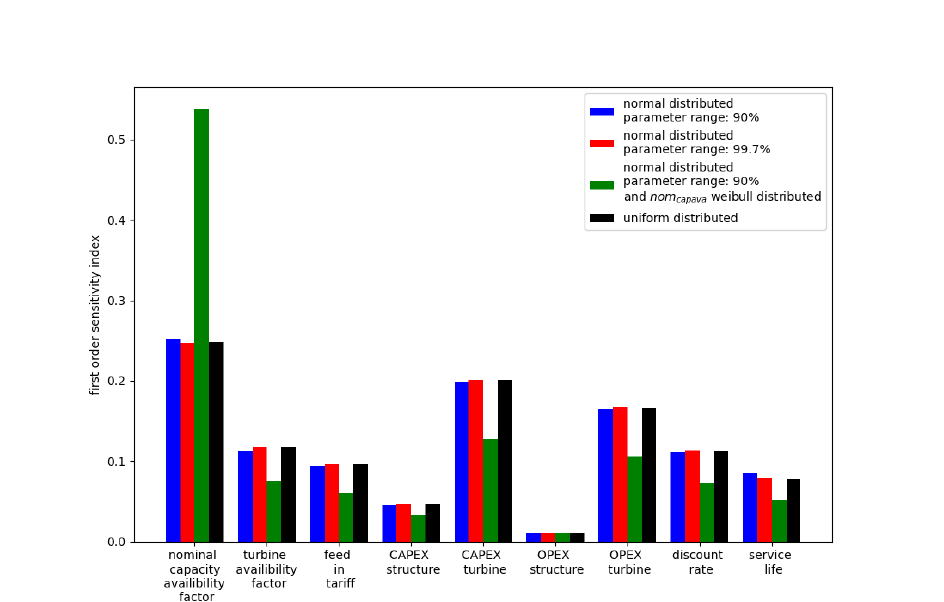
Figure 3. First order sensitivity indices of the parameters influencing the LCoE.